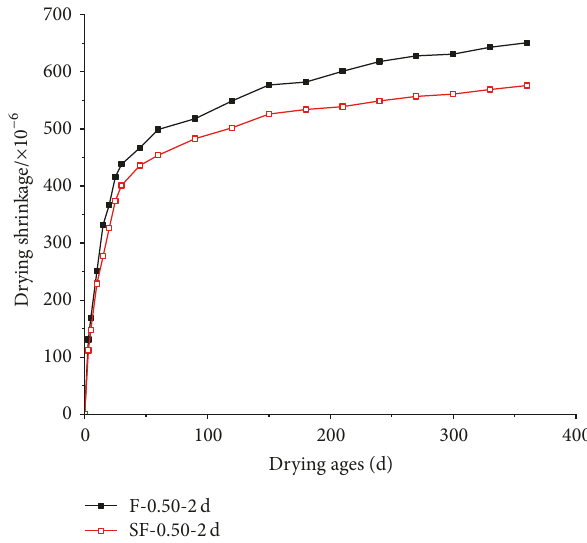
Figure 12: Drying shrinkage of fly ash concrete and SGGBS-fly ash